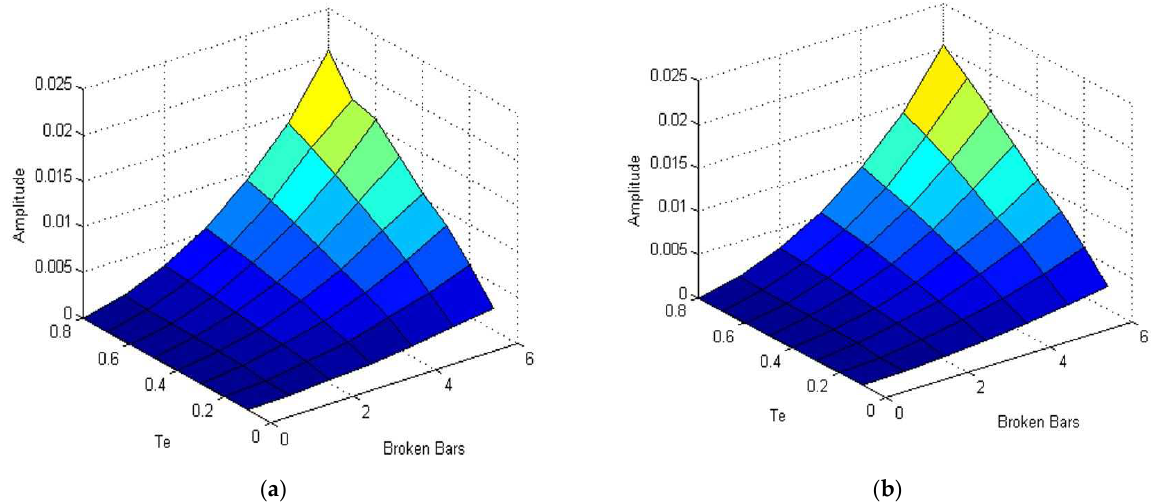
Figure 3. The amplitude of the rotor fault related harmonic obtained using ( a ) RDFT and ( b ) Goertzel’s algorithm for a variable number of broken rotor bars.